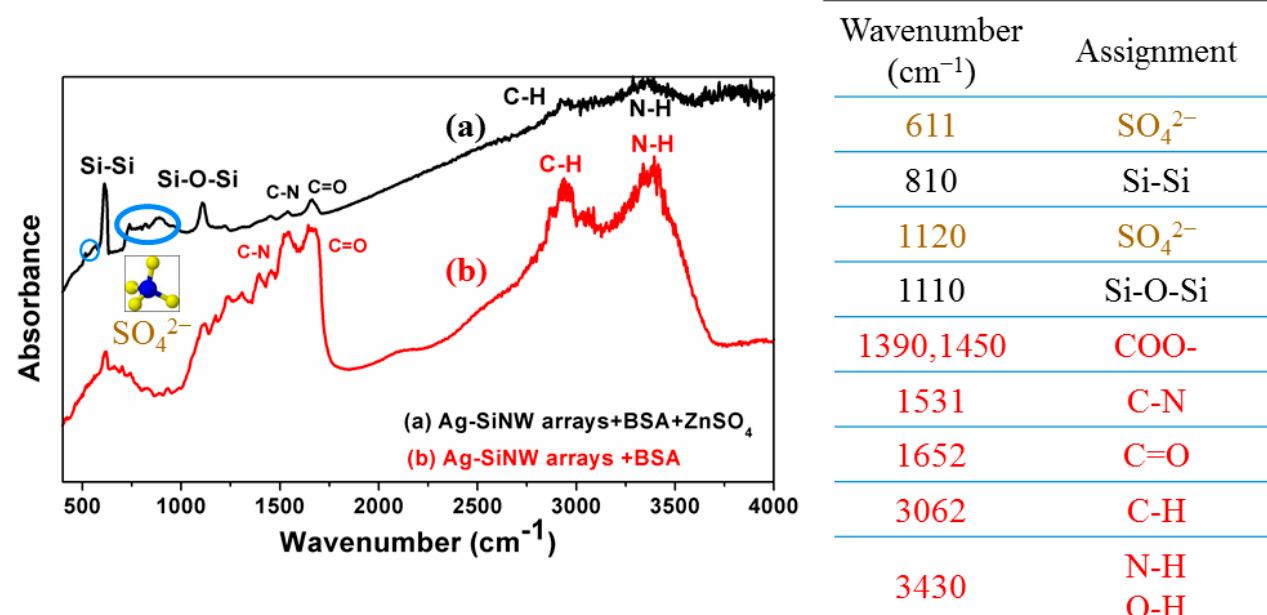
Figure 8. Comparison of FTIR spectra of the Ag–SiNW arrays ( a ) before the immobilization of BSA (black line) and ( b ) after immobilizing BSA (red line).